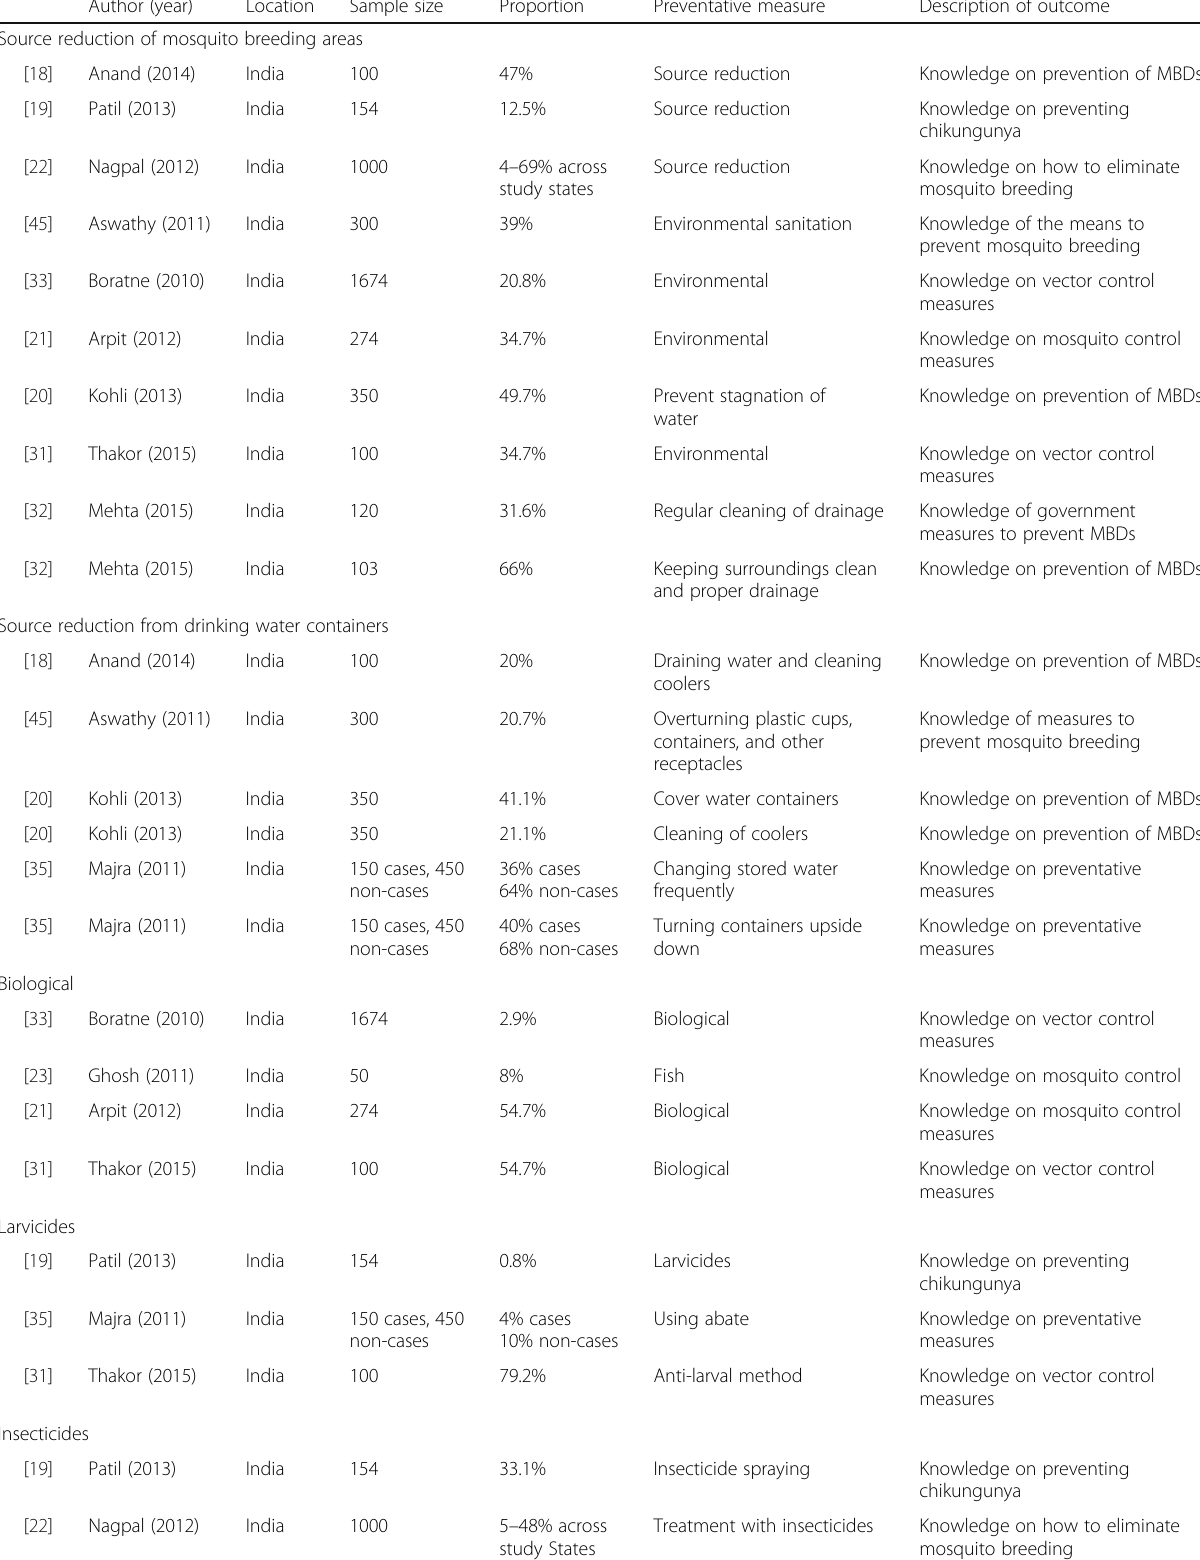
Table 4 Knowledge of the general public on vector